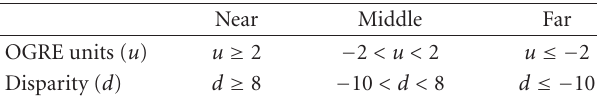
Table 4: Clustering units.